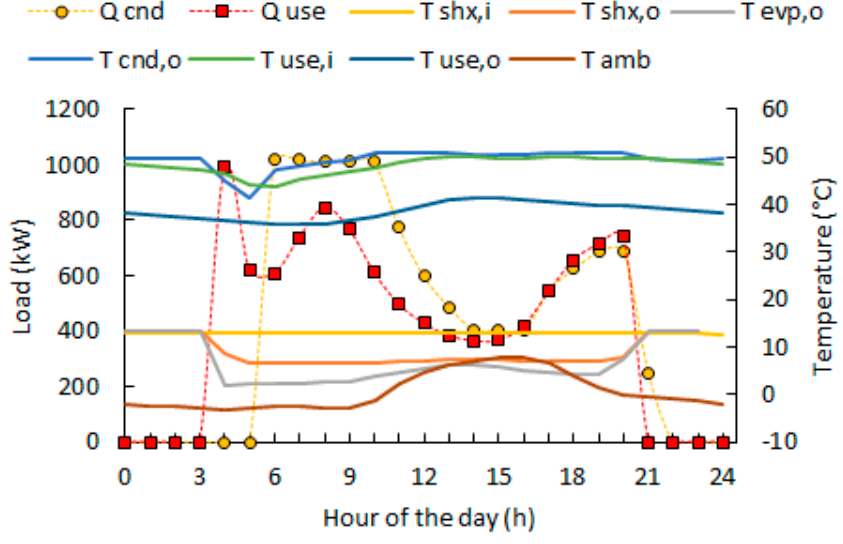
Figure 15. Transient operation in heating mode (clean SHX).